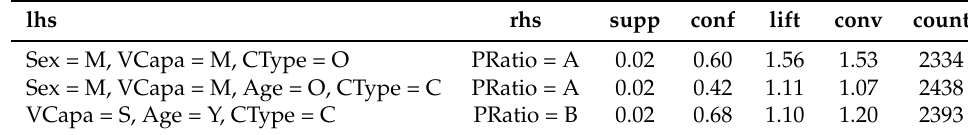
Figure 6. Graph of association rules for premium ratio. Table 6. Association rules for premium ratio based on policy